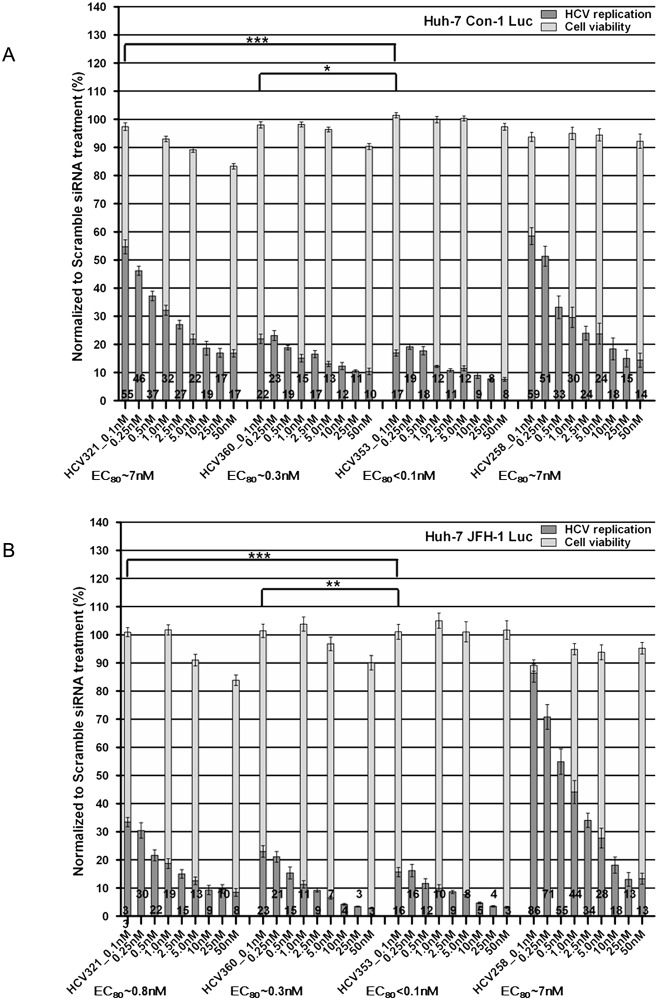
Dose-dependent antiviral effects of HCV IRES-specific siRNAs on the replication of subgenomic HCV replicons expressing Firefly luciferase.Luciferase replicon cells: (A) Huh-7 Con1 and (B) Huh-7 JFH-1 replicon cells were plated and transfected with 0.1–50 nM siRNAs. At 72 h post-transfection (p.t.), cells were harvested for luciferase activity measurement. Firefly luciferase activity (HCV RNA replication) and cellular ATP content (cell viability) of the scrambled siRNA transfection were set to 100% and used to normalize the relative luciferase activities of all other siRNA-transfected cells. Data are presented as the mean ± SEM values of four wells measured in duplicate in two independent experiments (N = 24). Black columns indicate HCV RNA replication; grey columns indicate cell viability. The numbers on the bars indicate the residual percentage of luciferase activity. Asterisks indicate that the mean values are significantly different between samples (*p<0.05; **p<0.01; ***p<0.001).